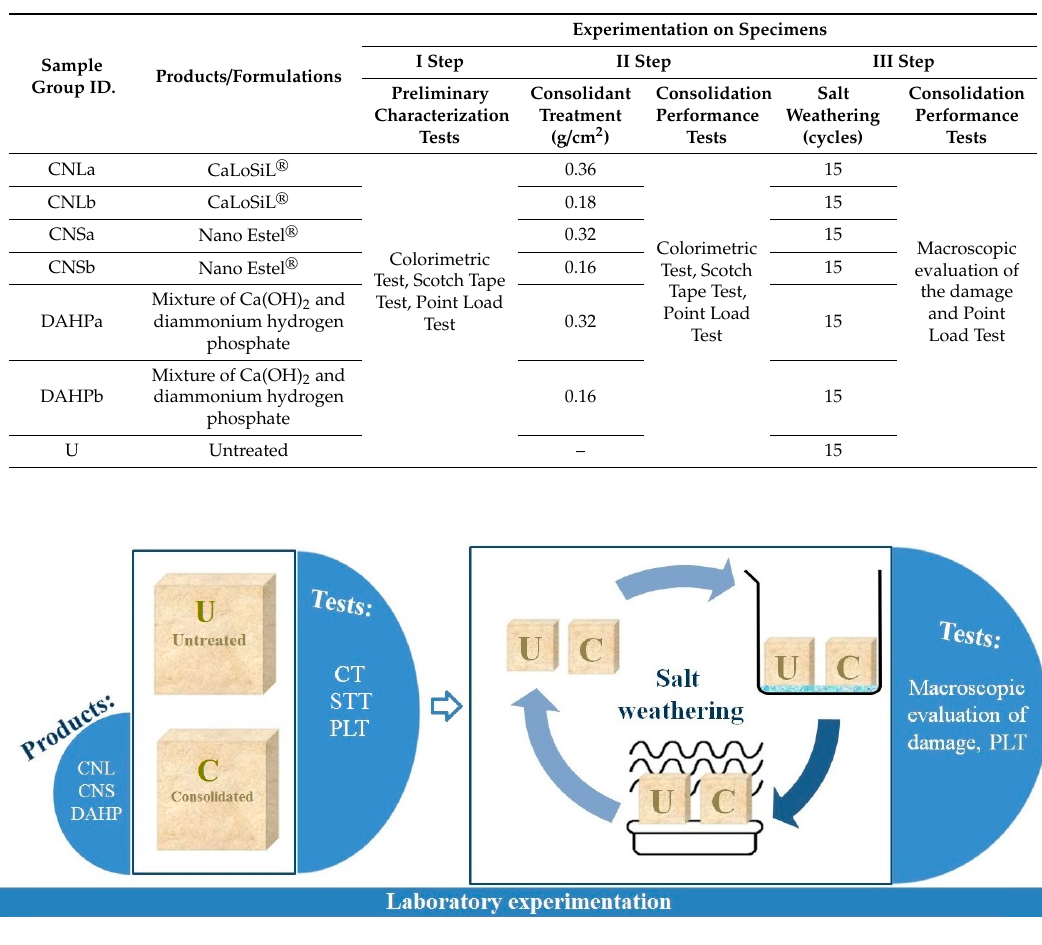
Figure 3. Scheme illustrating the experimentation workflow.